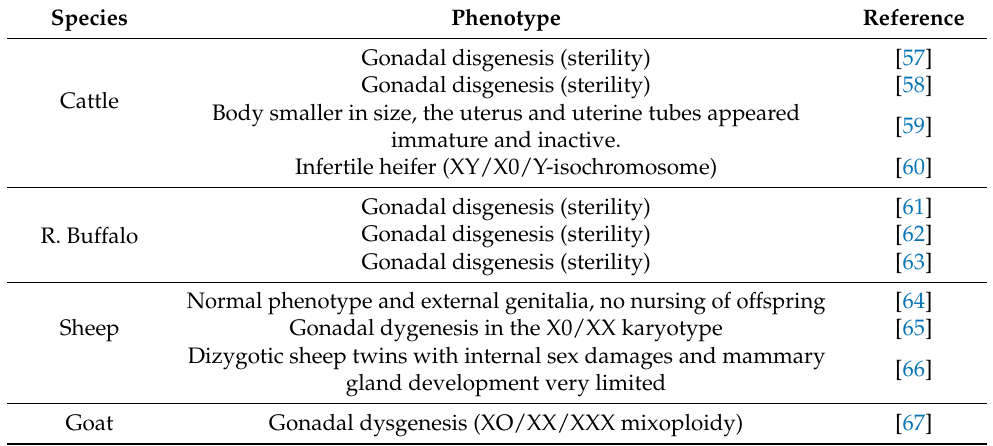
Table 4. X-monosomy in domestic bovids.